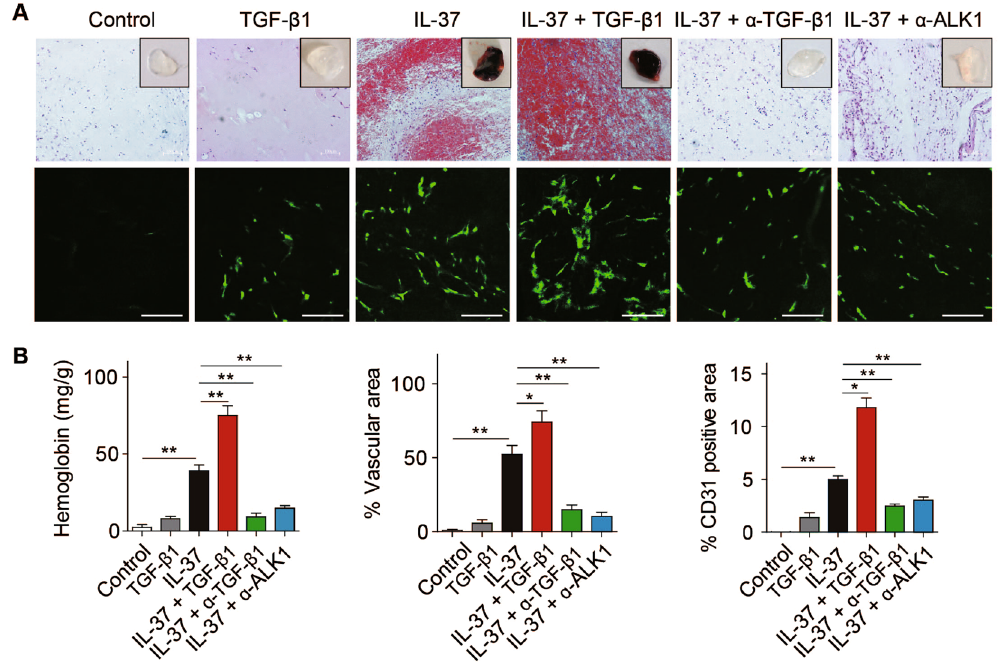
Figure 5. The pro-angiogenic effect of IL-37 was mediated by TGF- β signaling in vivo . ( A ) Representative images of Matrigel plugs incorporated with IL-37 (50 ng/mL) or/and TGF- β 1 (50 ng/mL) or indicated neutralizing antibodies (10 μ g/mL). Representative pictures of hematoxylin and eosin-stained sections and CD31 immunofluorescence-stained sections were shown. Scale bars, 100 μ m. ( B ) Aggregate analysis of hemoglobin content, percentage of vascular area and percentage of CD31-positive area per field of Matrigel plugs. n = 8 per group. Data are presented as mean ± SEM. * P < 0.05, ** P < 0.01 and *** P <